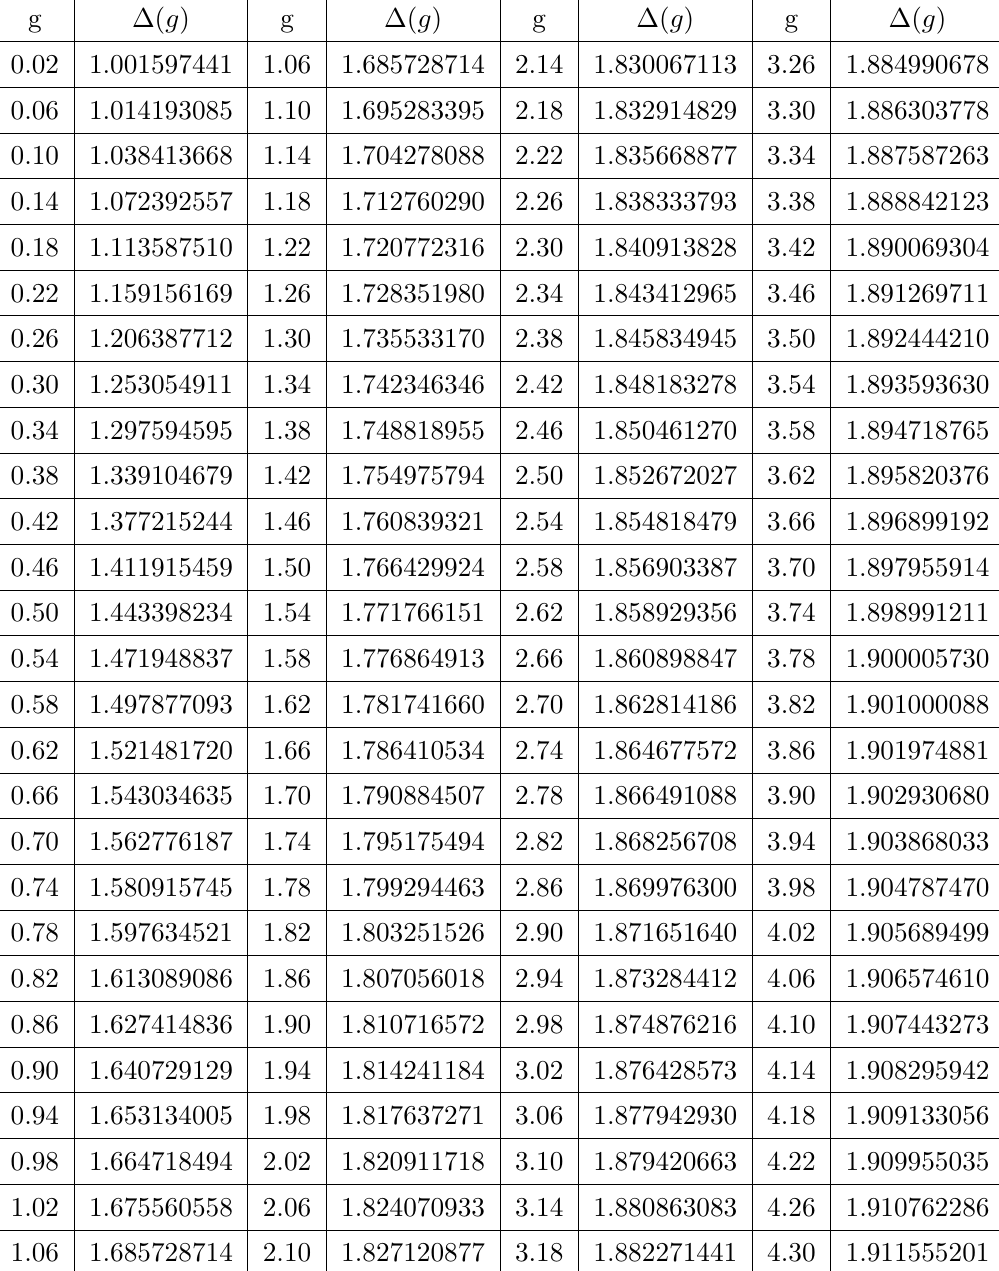
Table 1 . This table contains the numerical values obtained for (cid:1)( g ) for the (cid:12)rst excited state in the limit where both angles (cid:30) and (cid:18) vanish. This corresponds to inserting a single scalar at a point along a straight Wilson line, where the scalar is the same as the ones coupled to the Wilson line. The data obtained is precise to at least 20 digits, the (cid:12)rst ten of which are included in the table.